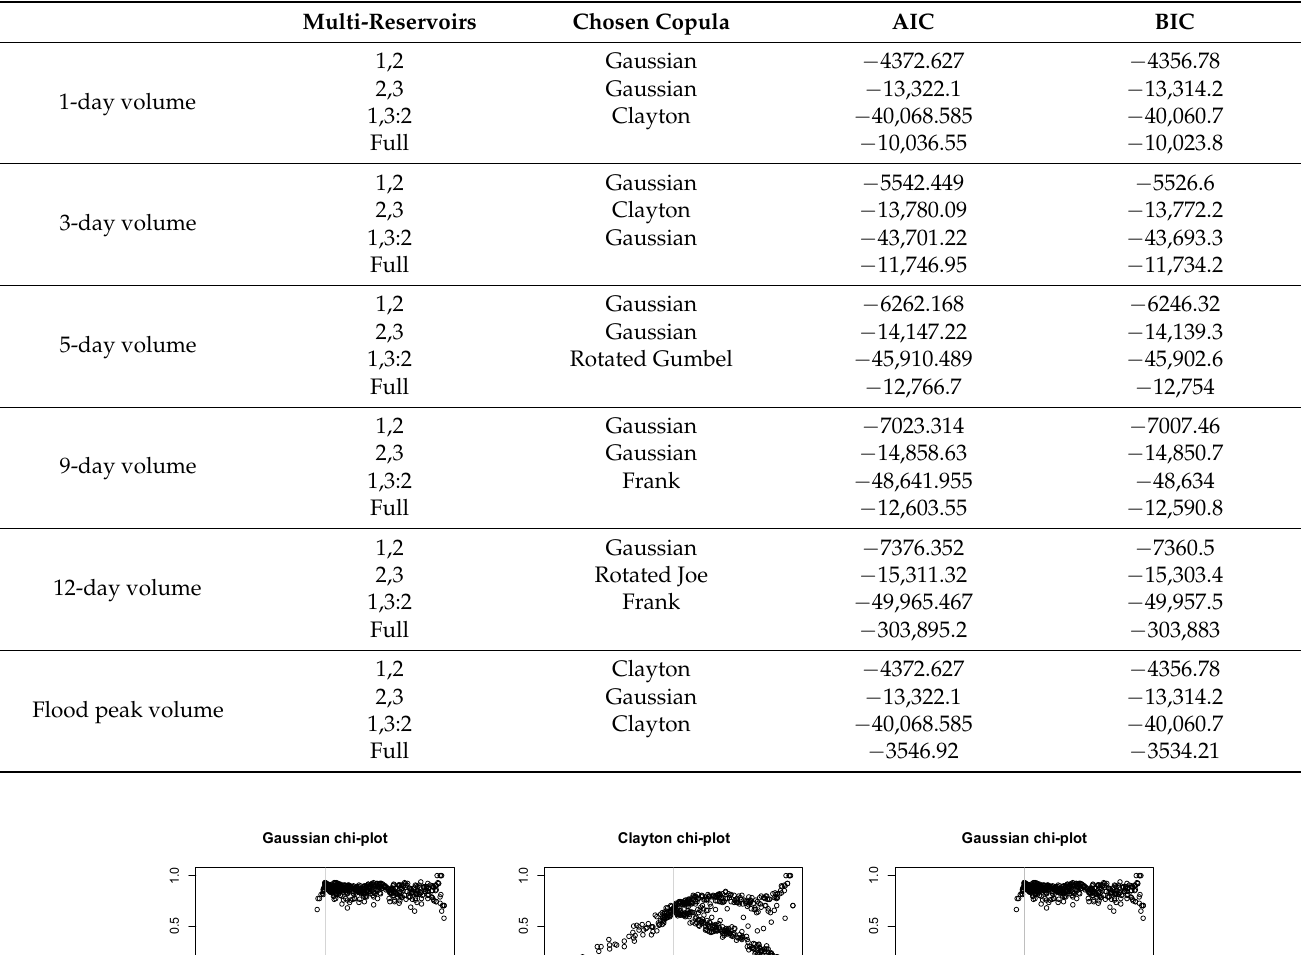
Table 2. Selected copulas for multi-reservoir joint flood risk distribution with minimum AIC and BIC.